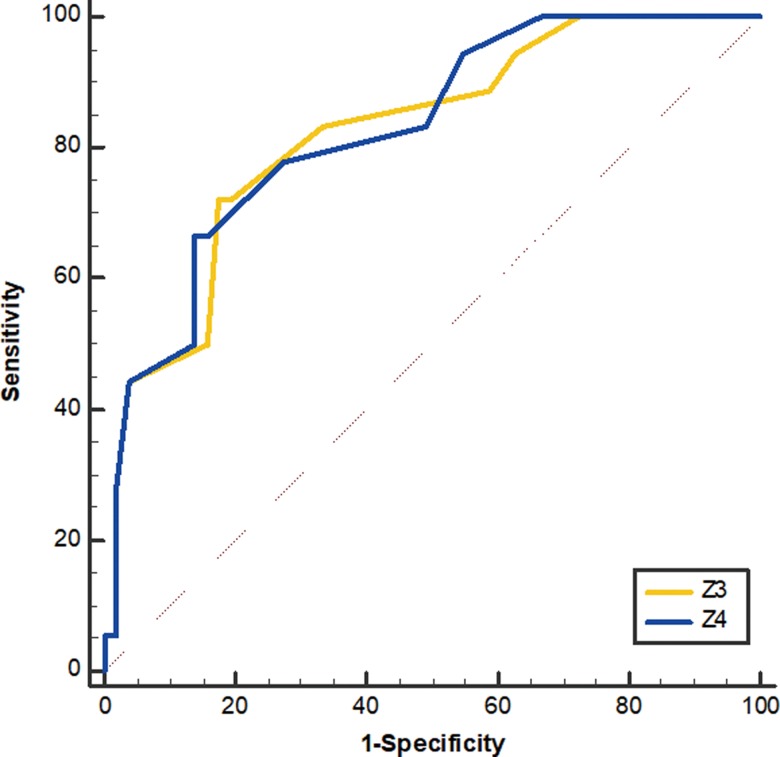
ROC curve of logistic regression equations in the non-mucinous adenocarcinoma subgroup.